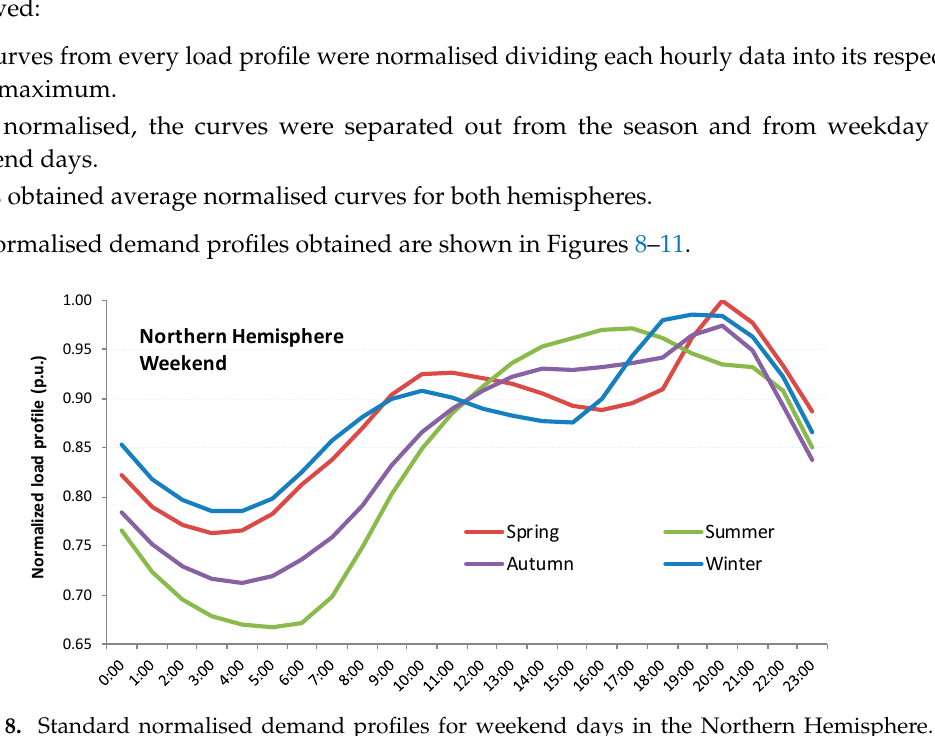
Figure 8. Standard normalised demand profiles for weekend days in the Northern Hemisphere. Energies 2019 , 12 , x FOR PEER REVIEW Source: [65,80–82] and self-elaboration.